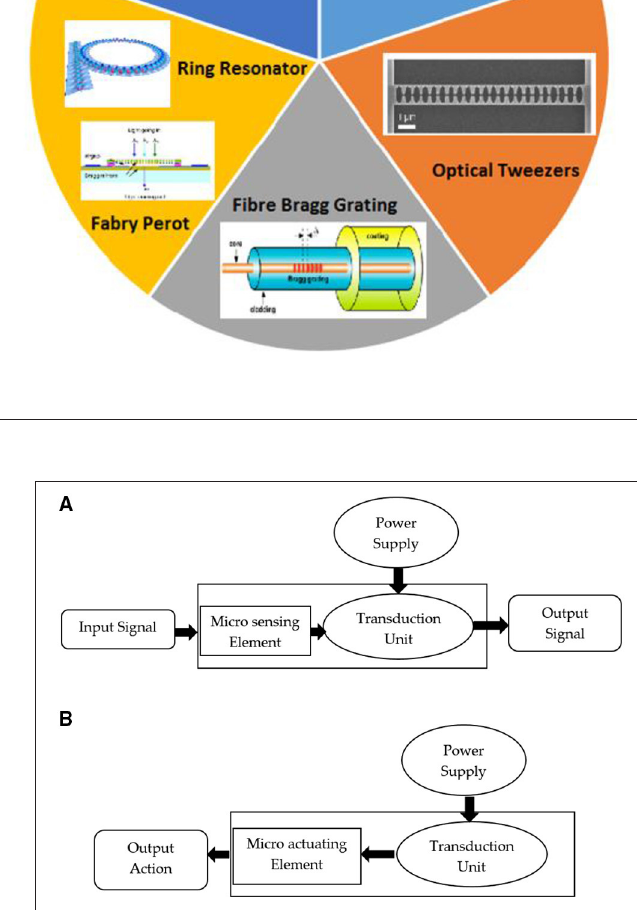
FIGURE 2 | (A) MOEMS as sensor, (B) MOEMS as